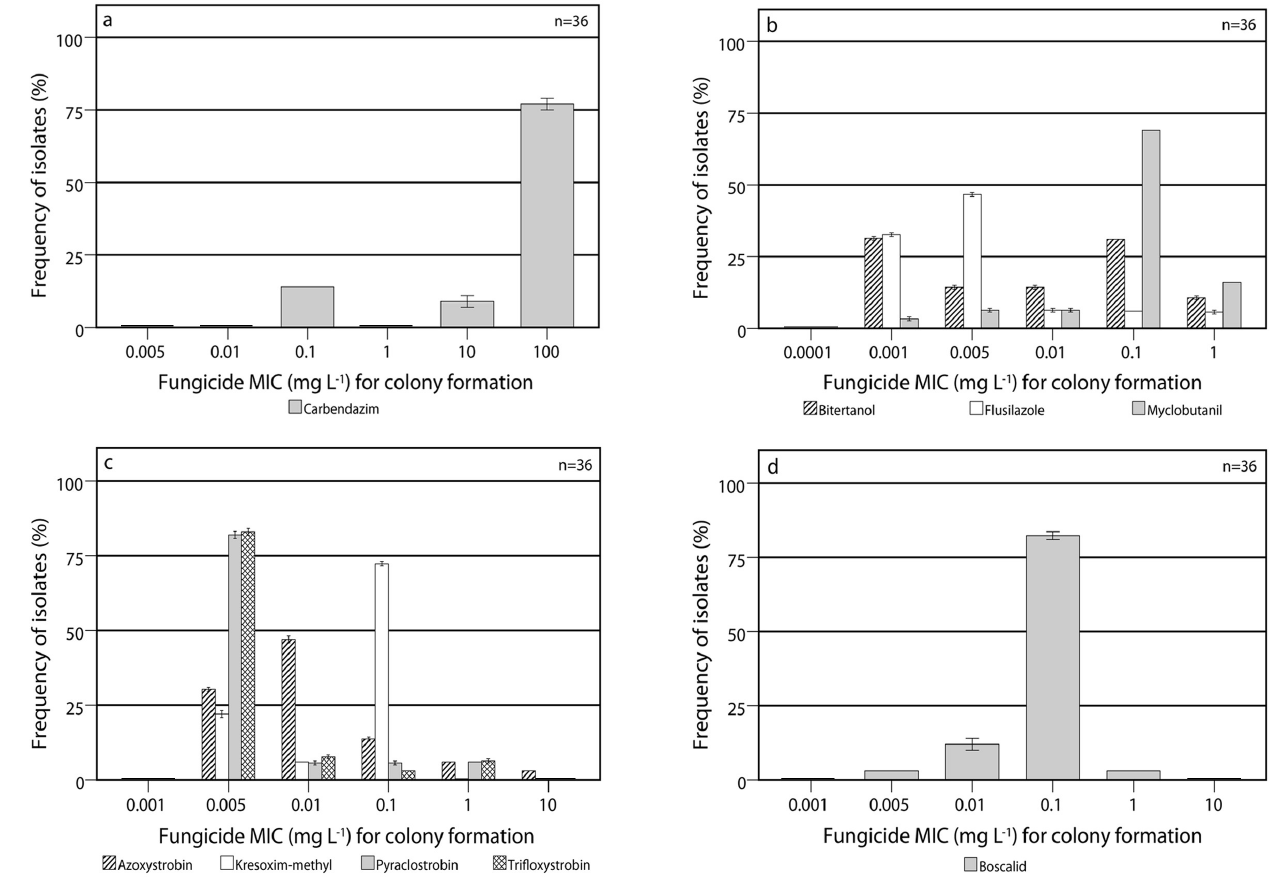
Figure 3. Frequency of sensitivity distribution for 36 Septoria pyricola isolates to various fungicides as studied on PDA amended medium by the point inoculation method. Bars represent 95% confidence